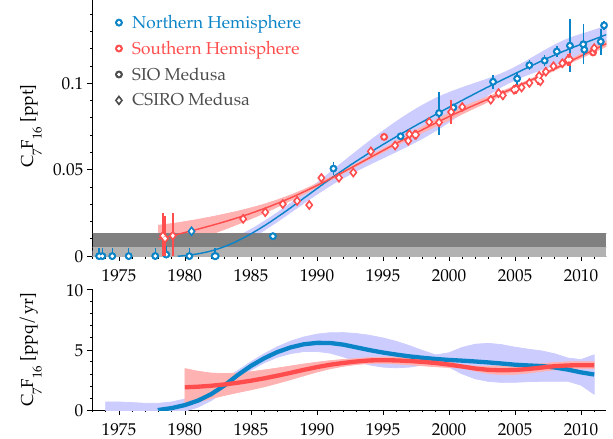
Fig. 4. Same as Fig. 1, but for C 7 F 16 .